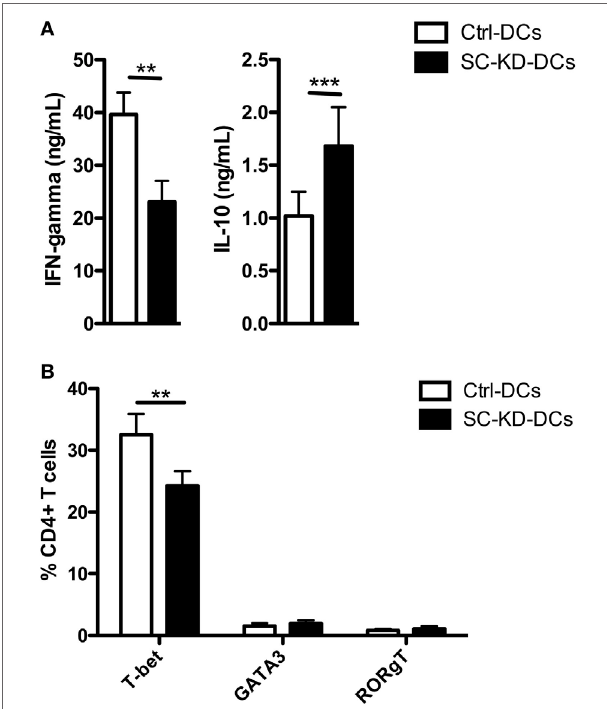
FigUre 5 | Knockdown of DC-SCRIPT in DCs polarizes T cells toward immunosuppression. Naïve CD4 + T cells were co-cultured with SC-KD-DCs or Ctrl-DCs until in a resting state after 10–12 days. Upon re-stimulation, the phenotype of the T cells were assayed for (a) expression of T cell subset markers by FACS and (B) secreted cytokines by ELISA ( n = 12 + SEM). Statistics: Student’s paired t test. ** p < 0.01, *** p <